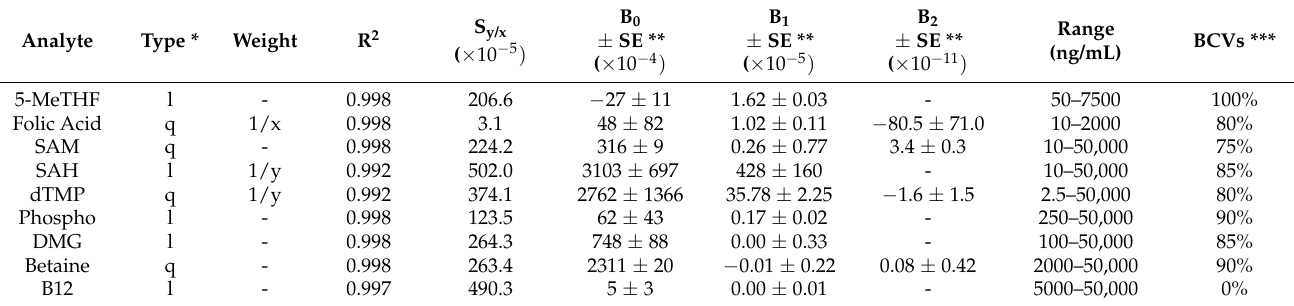
Table 1. Quality characteristics of the calibration curves of the substances. The actual dynamic range of the B12 calibration curve was far higher than the corresponding plasma levels of the substance, therefore it was not considered. * q = quadratic l = linear; ** SE = standard error; *** BCV’s = back calculated